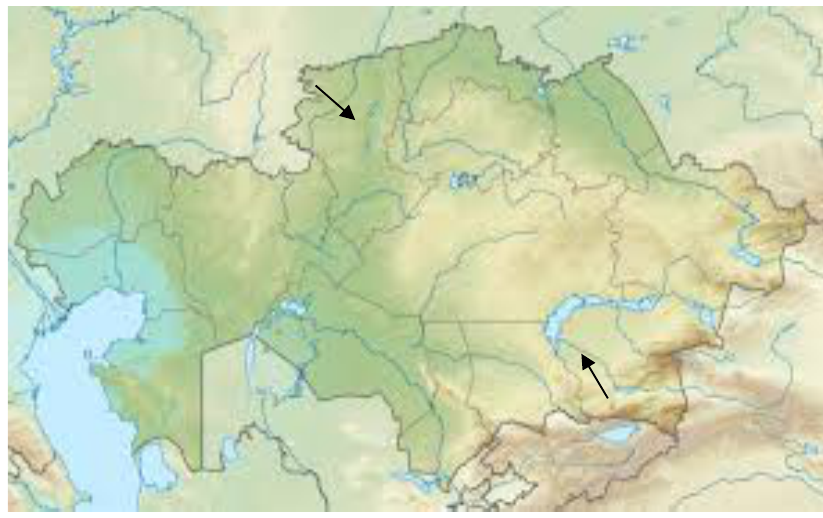
Figure 1A. Map of field trips collecting soil